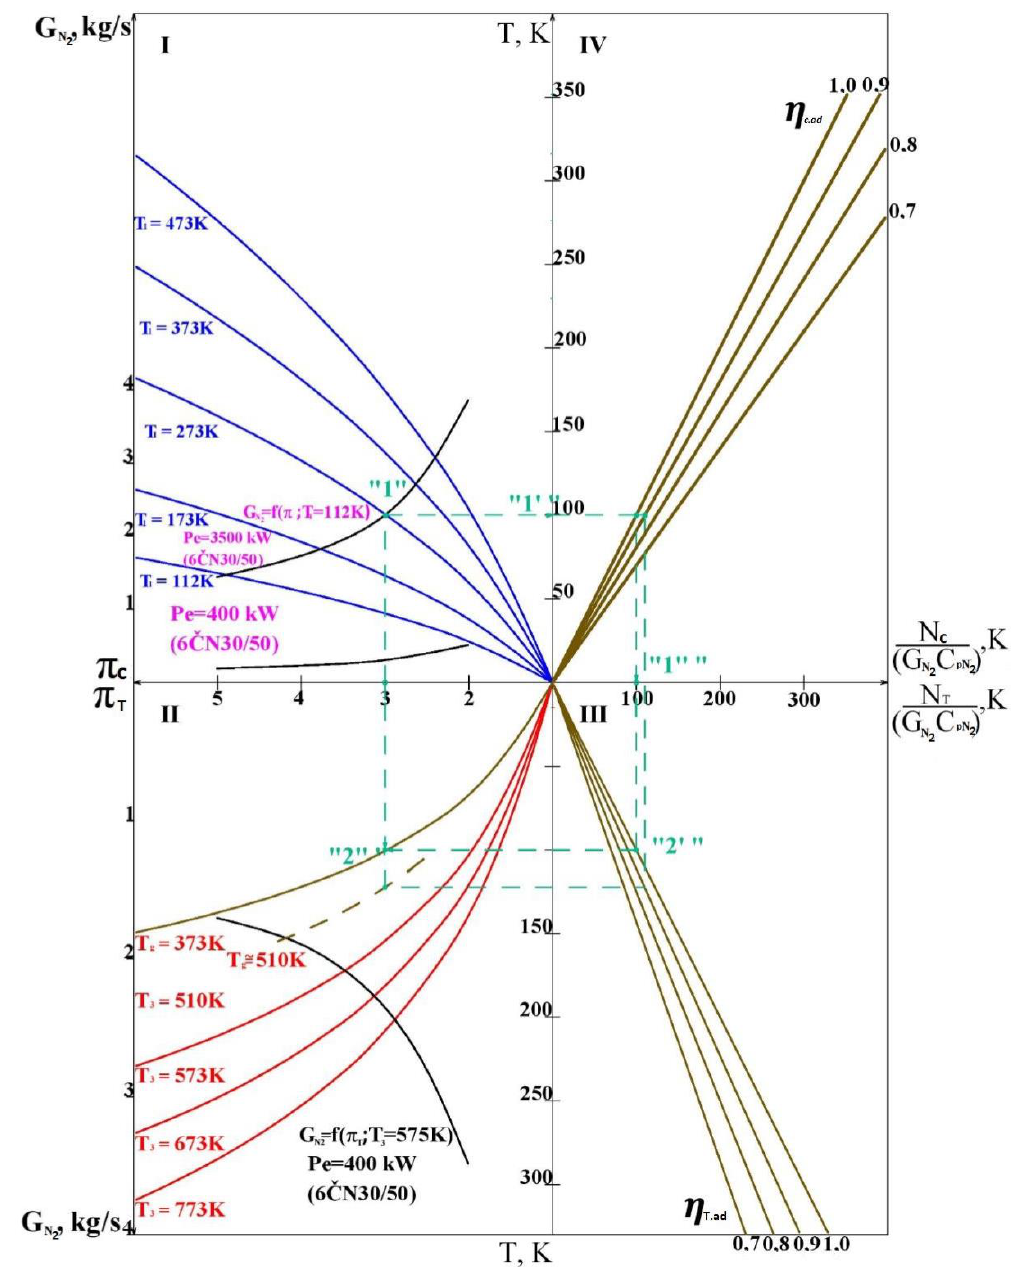
Figure 4. Nomogram of the effect of the cogeneration cycle parameters on energy efficiency.